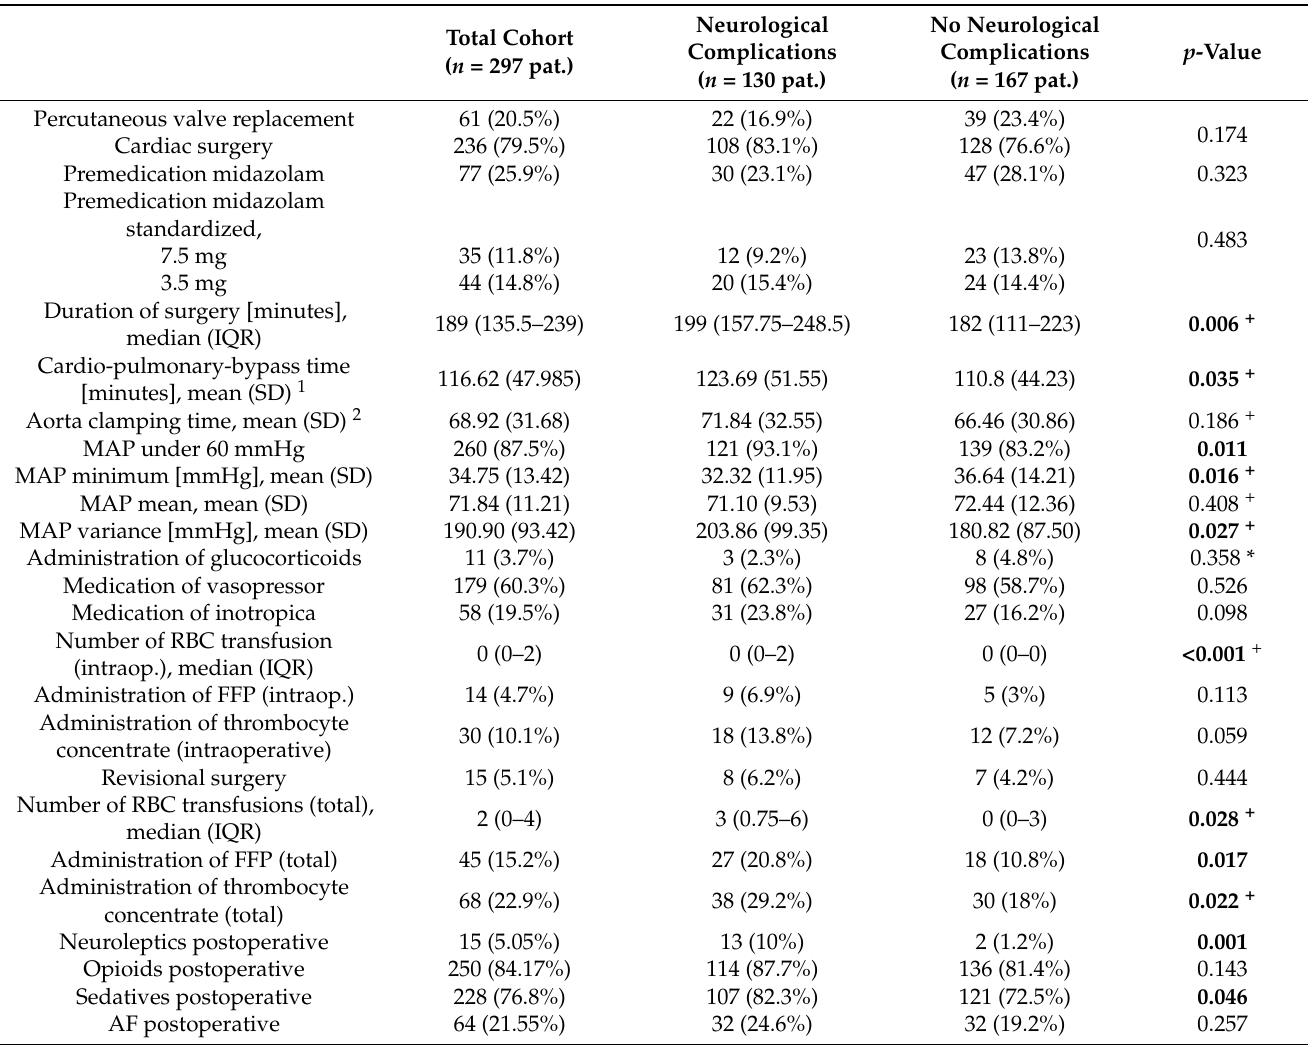
Table 2. Perioperative parameters for patients with or without neurological